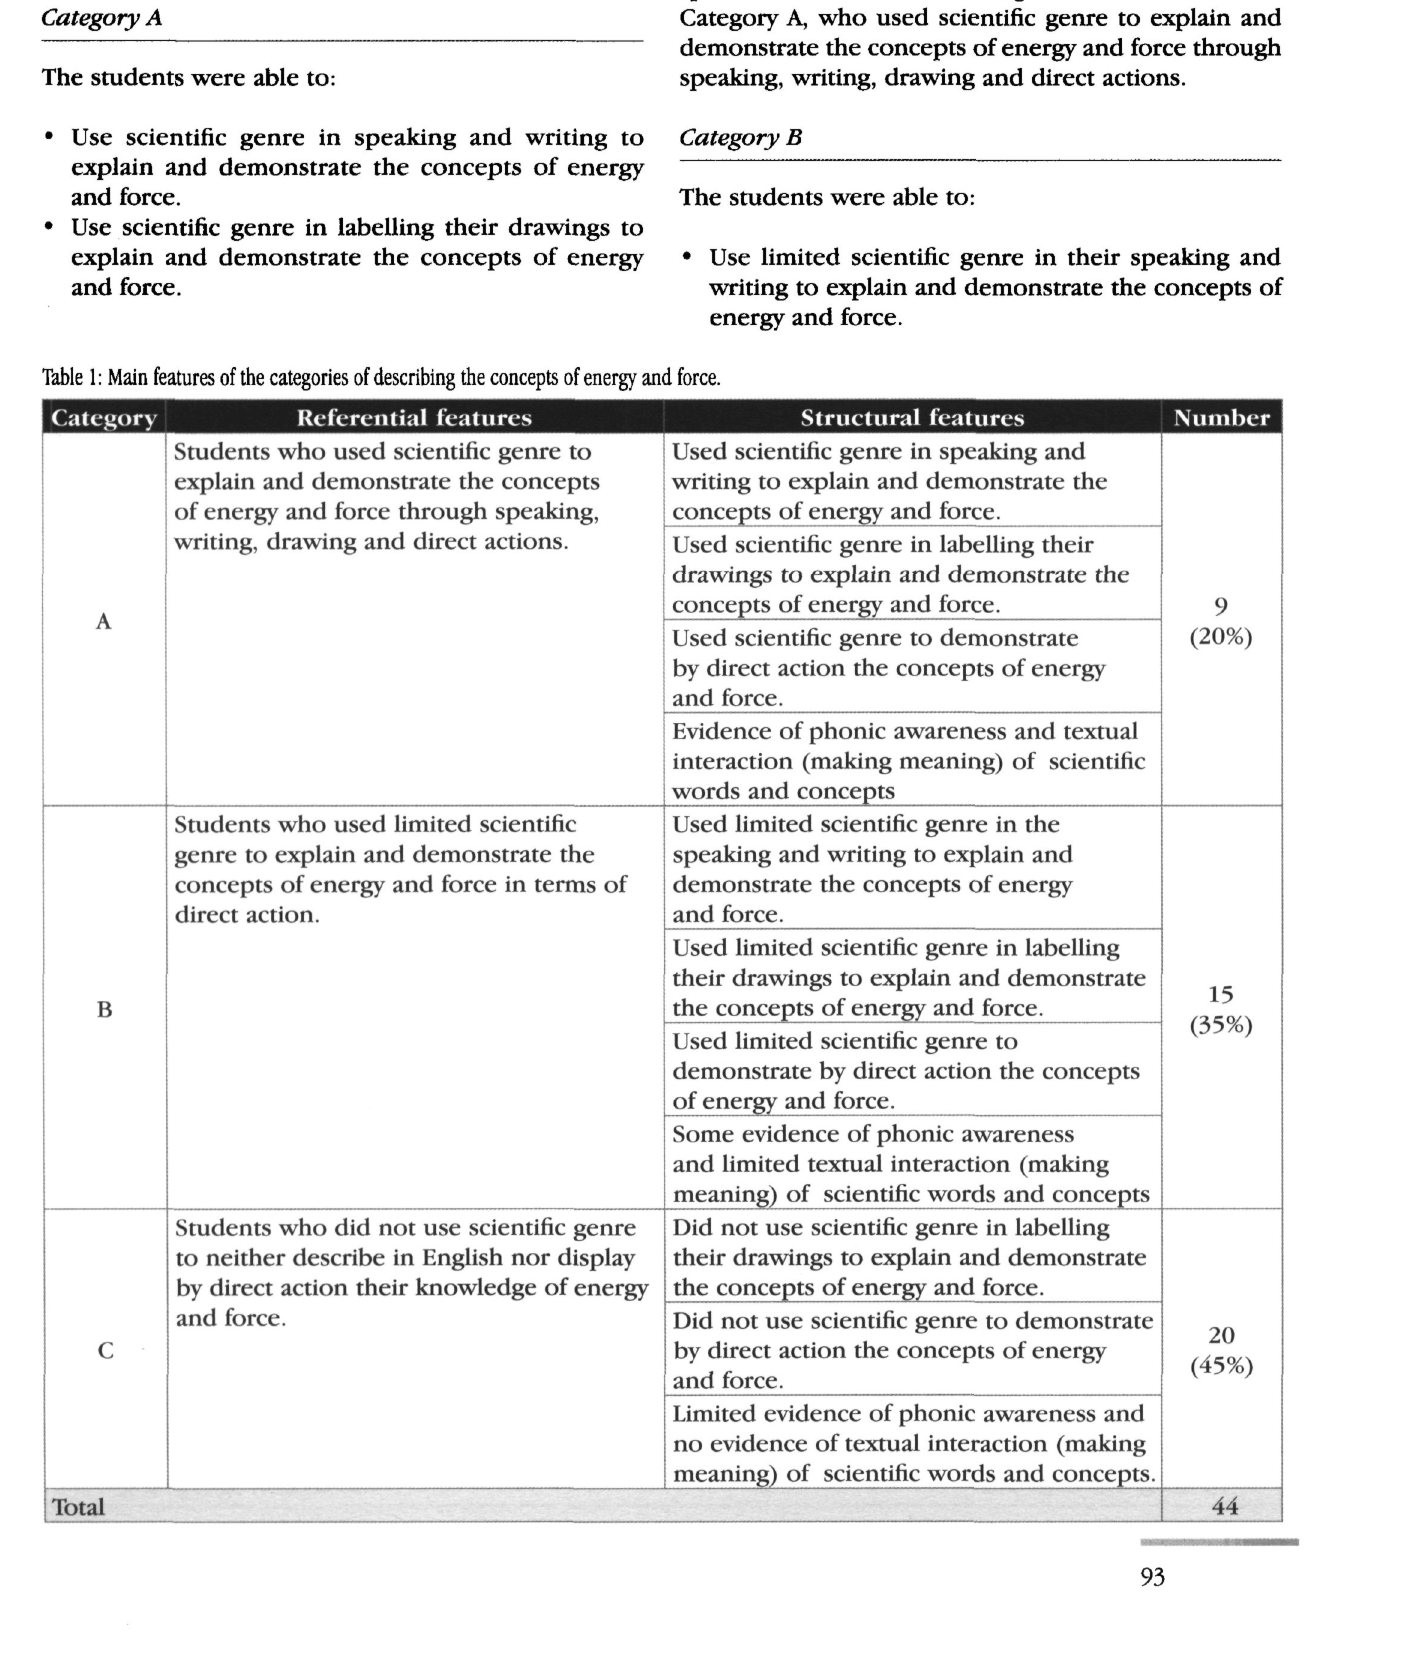
Table 1: Main features of the categories of describing the concepts of energy and force.